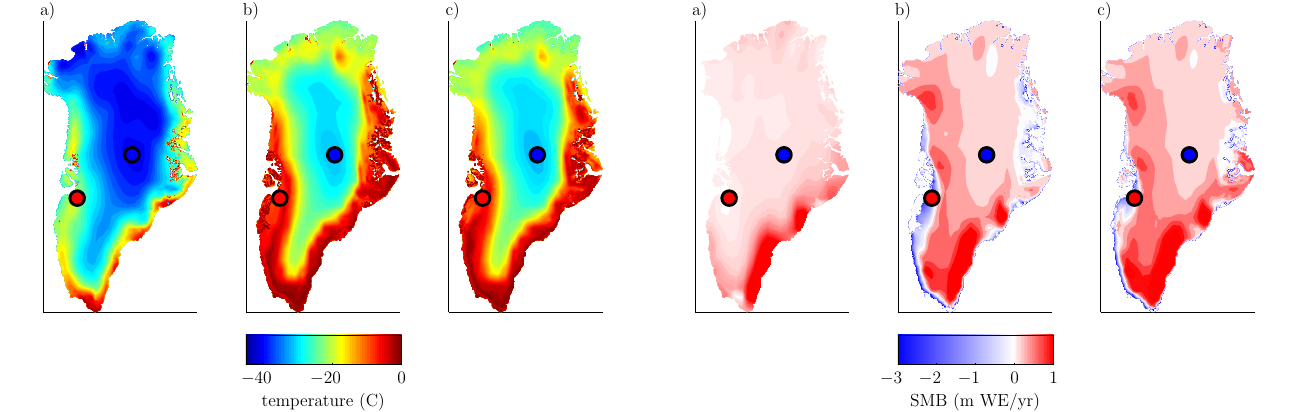
Figure 2. 30-year climatological annual average surface tempera- ture fields for the LGM (a) , MHO (b) and preindustrial (c) end- member climate states. Blue/red circles: location of the sum- mit/margin temperature time series presented in Fig. 4.